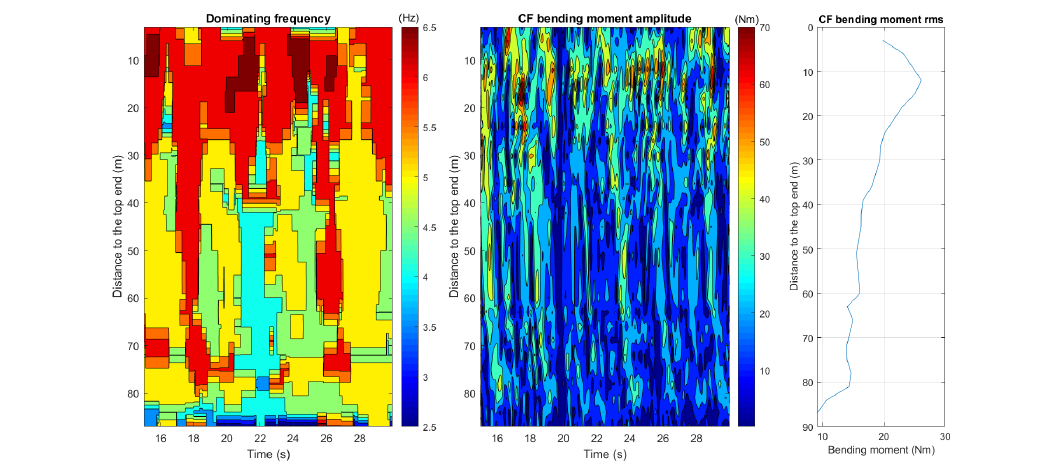
Figure 2. Multi-frequency response, high mode ( ∼ 25), bending stiffness dominating, Hanøytangen test case 0056